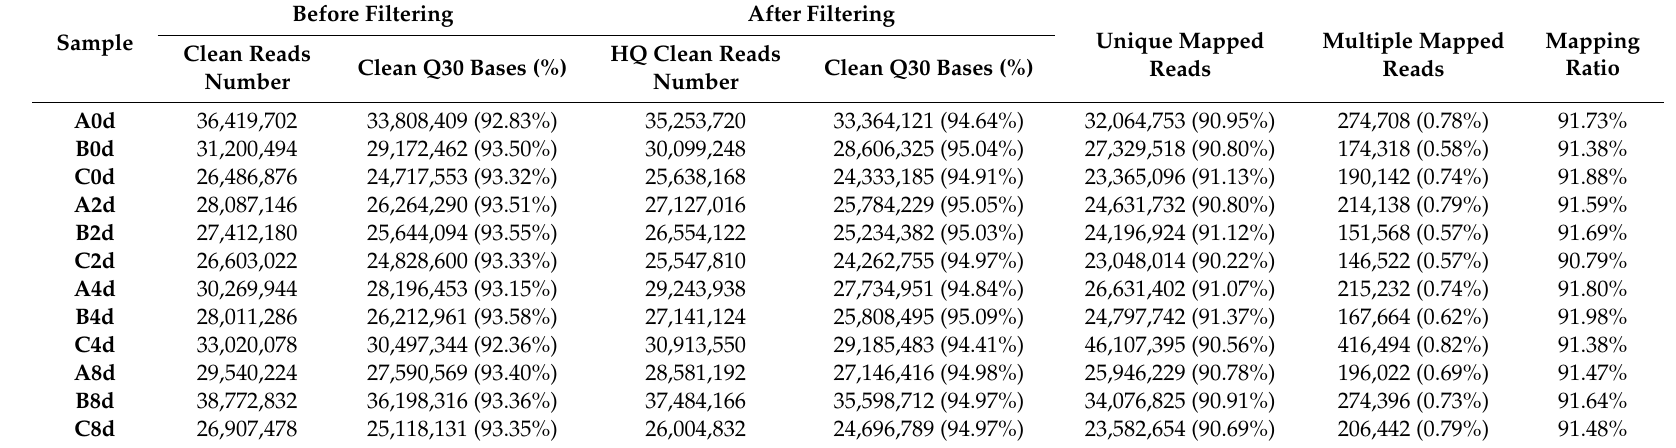
Table 1. Summary of RNA sequencing (RNA-seq) data in four stages of preadipocyte di ff erentiation. HQ—high